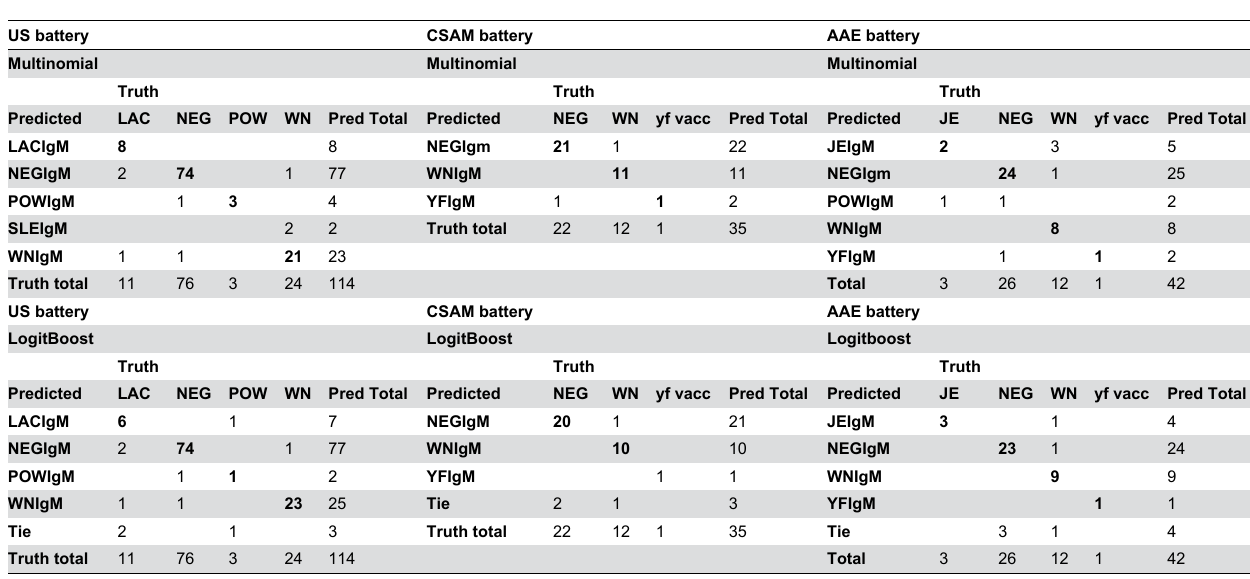
Table 8. Multinomial and Logitboost outcomes for CSF.